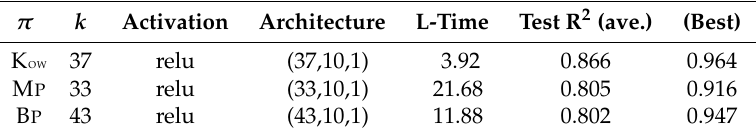
Table 2. Results of Steps 2 and 3 in Phase